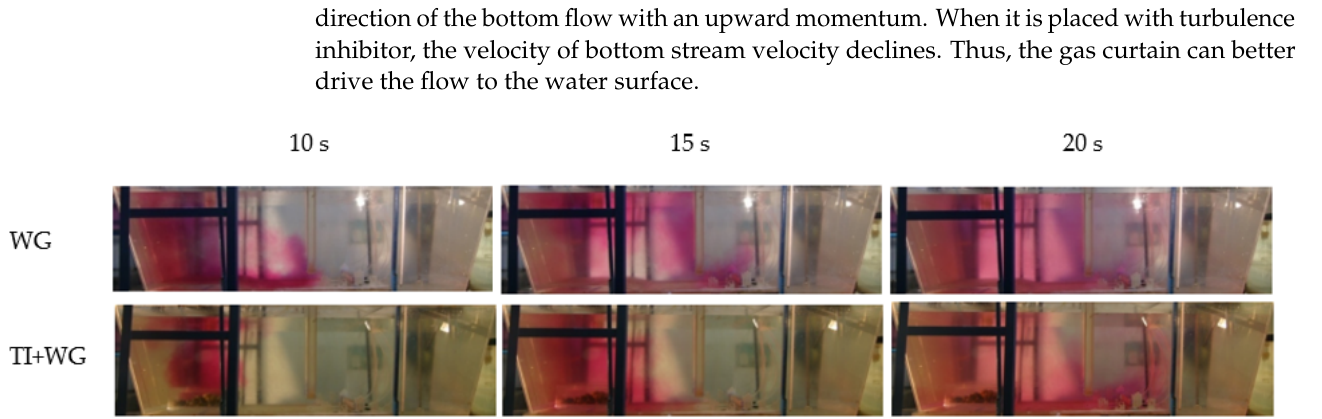
11 of 20 Figure 6. Comparison of measured RTD curves between three cases: bare, WD and TI + WD (theo- retical residence time = 834 s). 3.1.2. Multiphase Experiments Other than the three above mentioned single-phase cases in Section 3.1.1, another